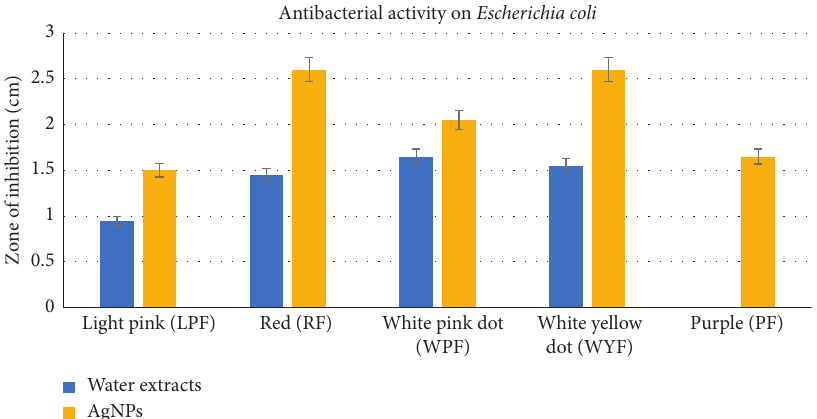
Figure 20: Antimicrobial activity of the water extracts and AgNPs against Escherichia coli.